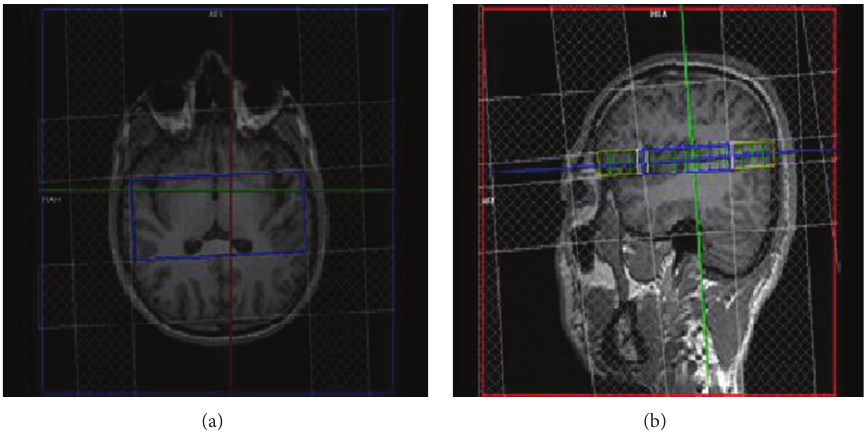
Figure 1: Representative two-dimensional multivoxel axial and sagittal positioning images. The central frame in the left image highlights the rectangular region of interest for data acquisition. The left image also illustrates that the acquisition region covers the bilateral auditory cortex. The right image demonstrates that the positioning image is parallel to the lateral fissure.